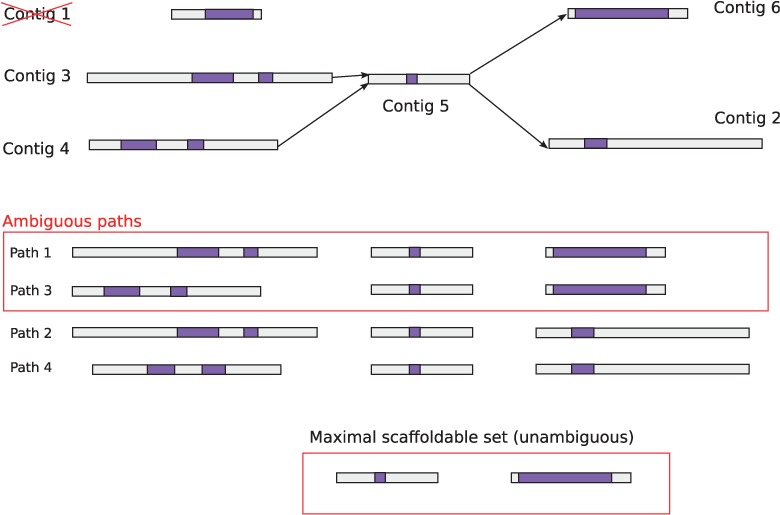
The scores for all possible
combinations of contigs in each region are computed (including combinations with no
contigs from clusters), and the lowest scoring paths are removed. The higher scoring
paths (with at least β times the highest scoring path) are then compared;
contigs present in the highest scoring (ambiguous) paths are kept and determine the
maximal scaffoldable set